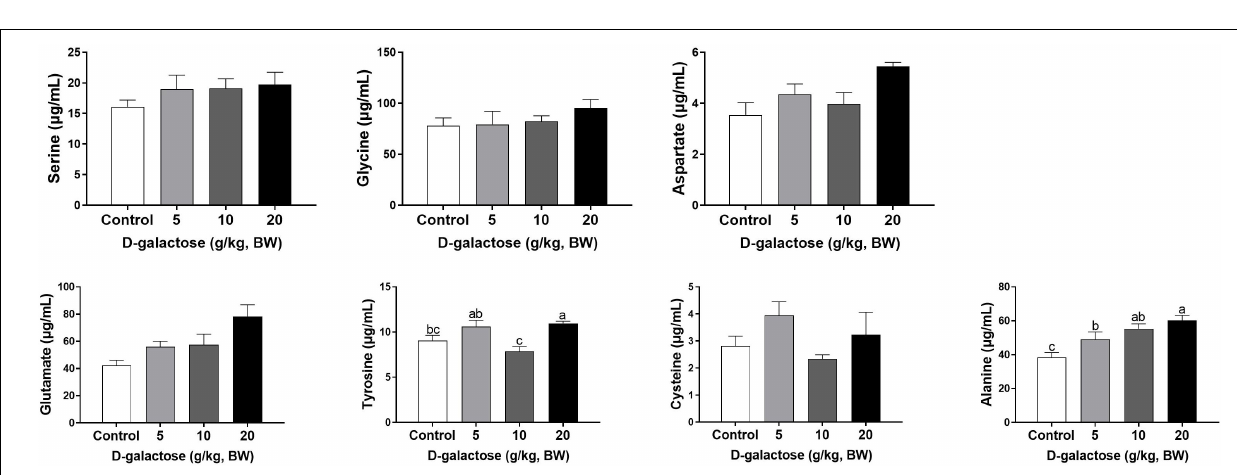
clustered into OTUs. To identify the microbial biodiversity, the reads were clustered into operation taxonomic units (OTUs) basing on 97%